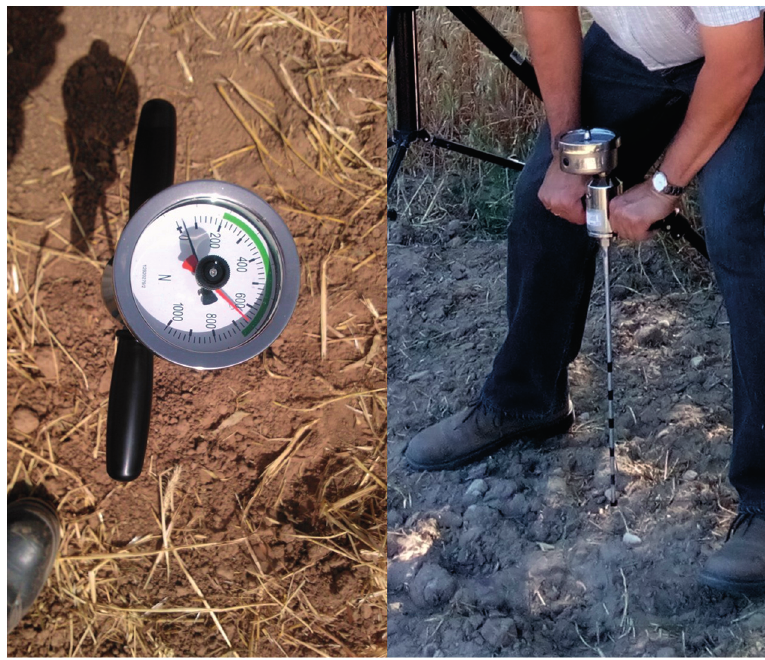
Figure 2. Penetrometer utilised during the experimental